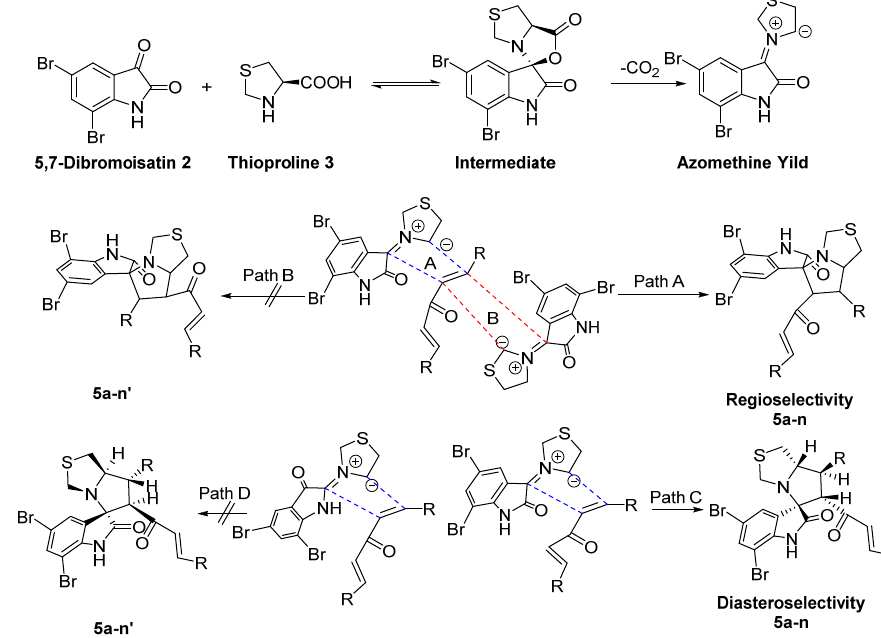
Table 1. Results of anticancer activity against HepG2, MCF-7, and HCT-116